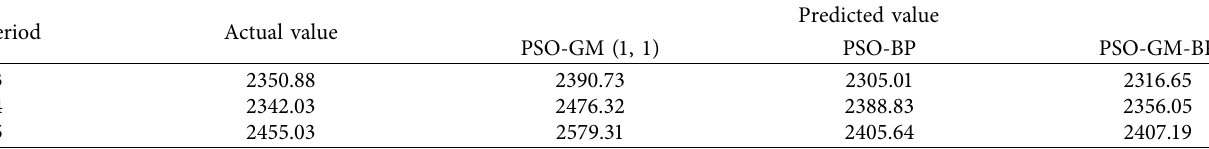
Figure 15: Residual test samples. Table 8: Comparison of three models.